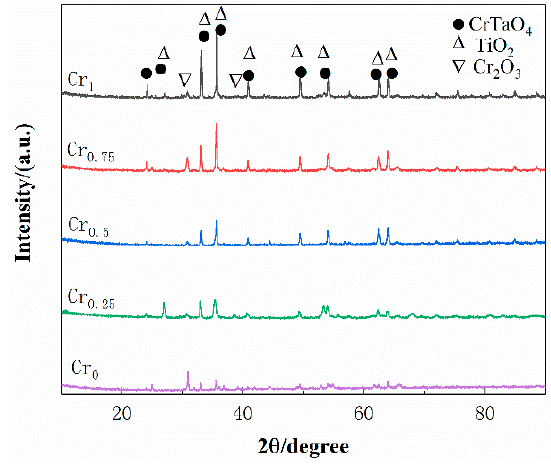
Figure 9. Surface oxide XRD of WVTaTiCr x RHEA coating.